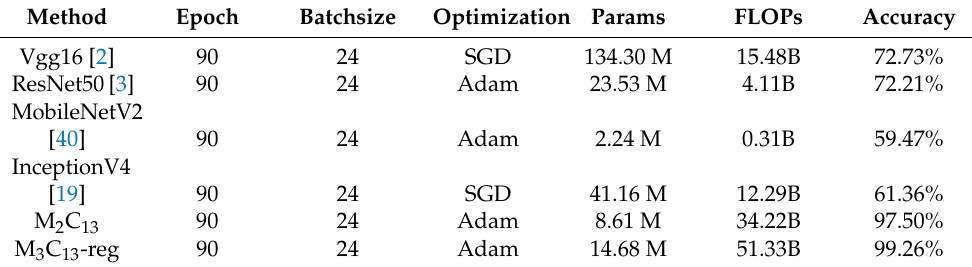
Table 4. Evaluation Results in the 10-Monkey Species